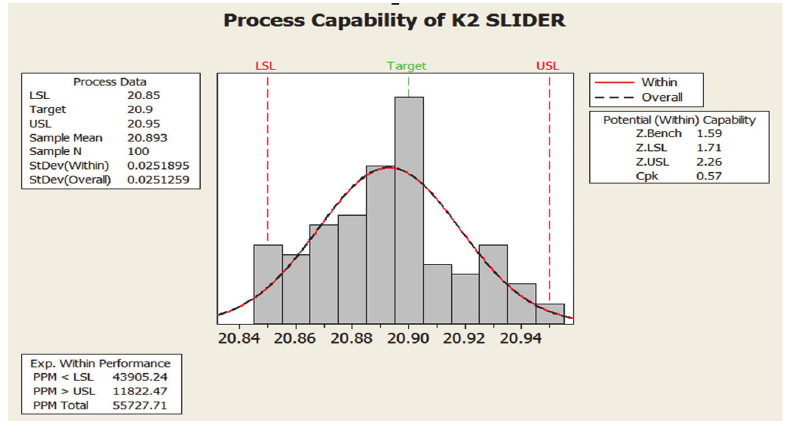
Fig. 6. Process Capability Analysis of Lock Nut